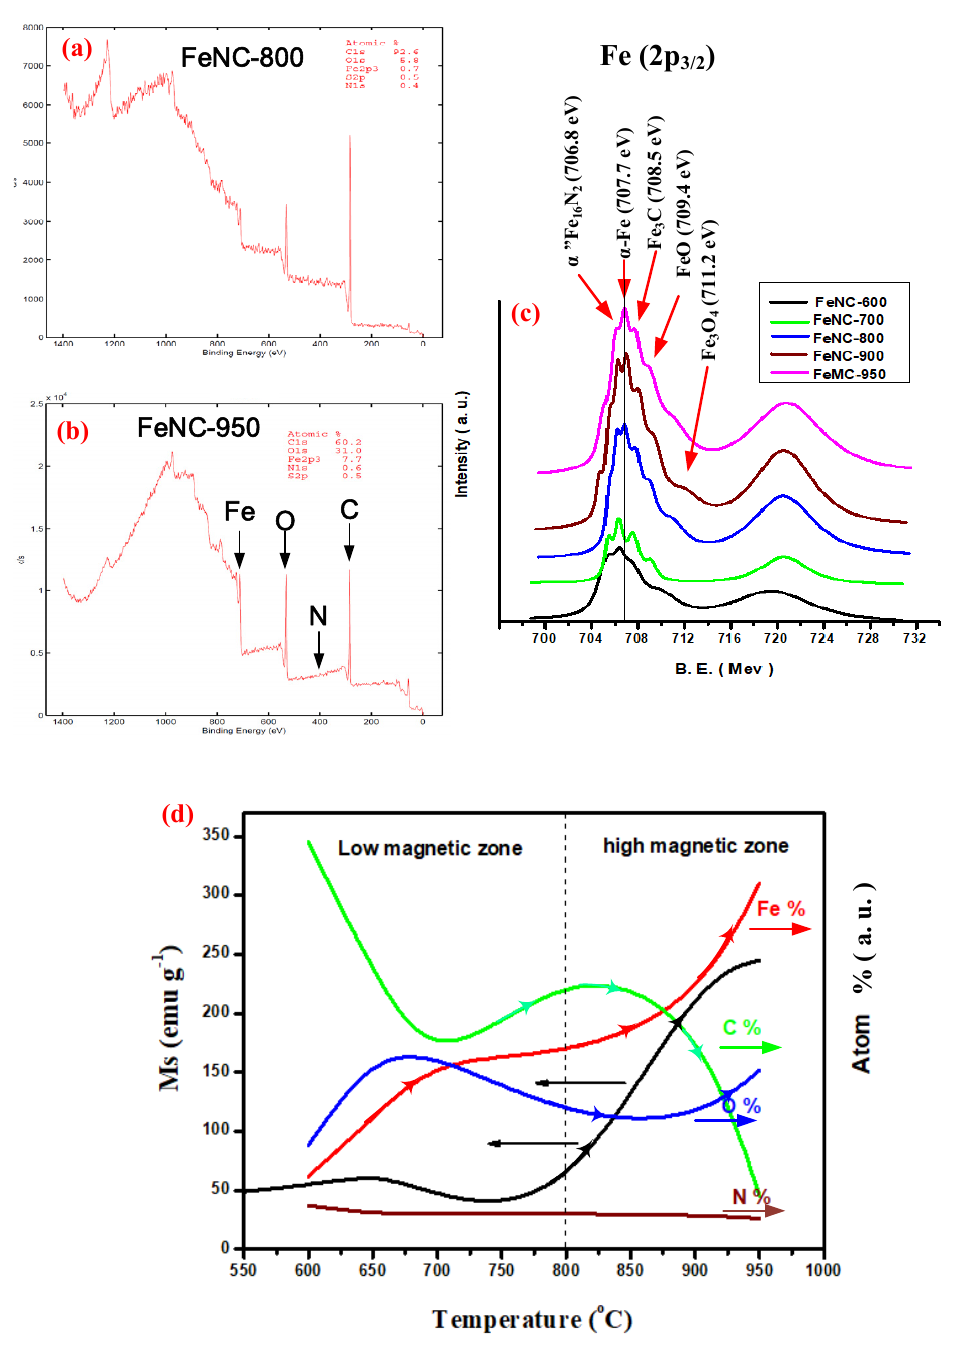
Figure 9. XPS spectra of ( a ) FeNC-800, ( b ) FeNC-950, ( c ) Fe (2p 3/2 ) of FeNCs, ( d ) specific magnetization (Ms) and various atom % of FeNCs at different temperatures.